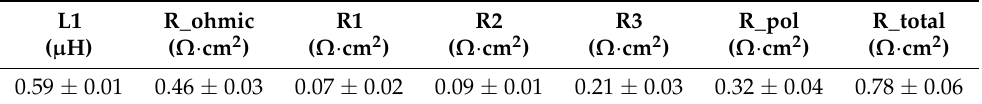
Figure 6. ( a ) The EIS plot of the printed single-layer cell sintered at 900 ◦ C. The measurement was conducted at 550 ◦ C under OCV conditions using a frequency range of 100 mHz to 100 kHz, ( b ) an equivalent circuit model that was used to fit the EIS plot. Table 2. Resistance values corresponding to fuel cell processes using the equivalent circuit shown in Figure 6b. The EIS measurements were carried out at 550 ◦ C on a single-layer printed cell sintered at 900 ◦ C with dimensions of 11.5 mm in diameter and a thickness of 1.65